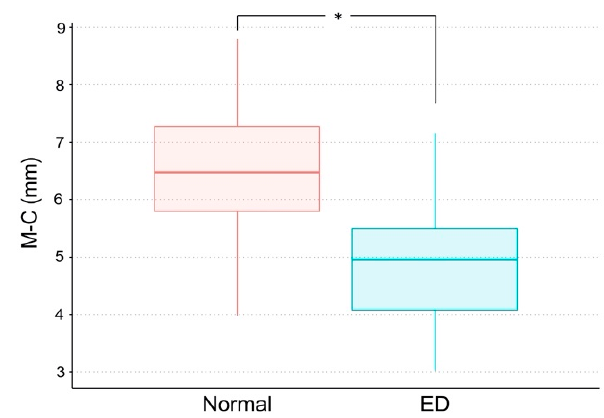
Figure 2. Box plot for comparison of the distance from the most inferior margin of the mandible to the center of the mandibular canal (M–C) in the normal and eruption disturbance (ED) groups. Asterisk (*) indicates a significant difference.